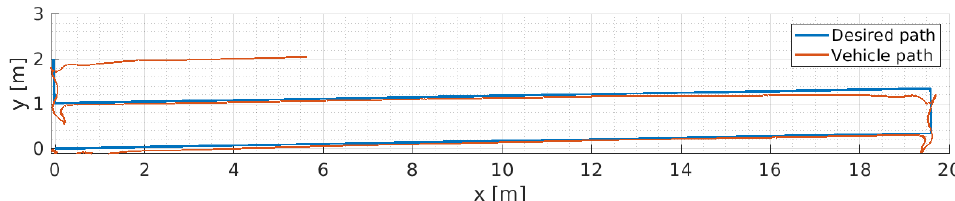
Figure 15. Simulation results for path following employing the modified controller with cross-current of 0.2 m/s.